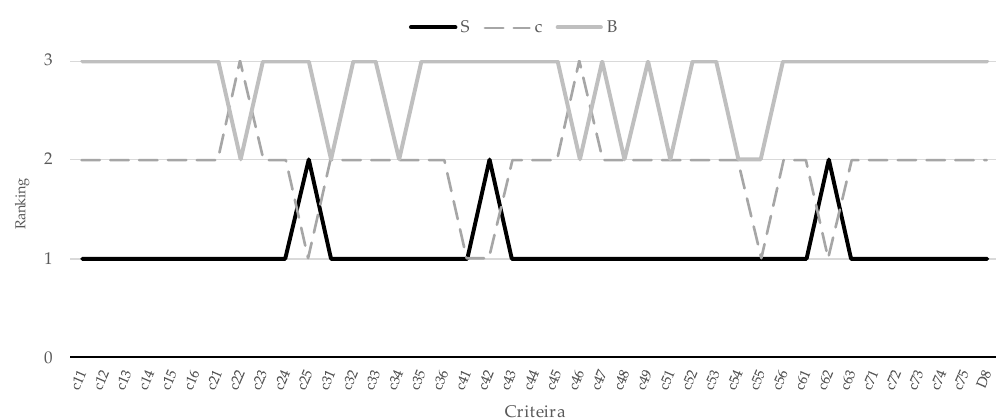
Figure 4. Results of the Experiment 1 of the Sensitivity Analysis.